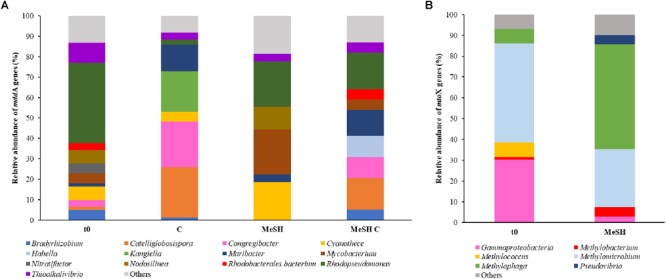
Diversity and relative abundance of mddA and mtoX genes in saltmarsh sediment unassembled metagenomes. (A) Only mddA genes with abundance of ≥ 5% in at least one of the conditions are represented. (B) Only mtoX genes that are at least ≥ 4% abundant in one condition are shown. C and MeSH plus C metagenomes are not represented as they yielded < 10 mtoX unique hits. t0: natural samples; C: enrichments with mixed carbon source; MeSH: samples enriched with MeSH-only; MeSH C: enrichments with MeSH plus C.